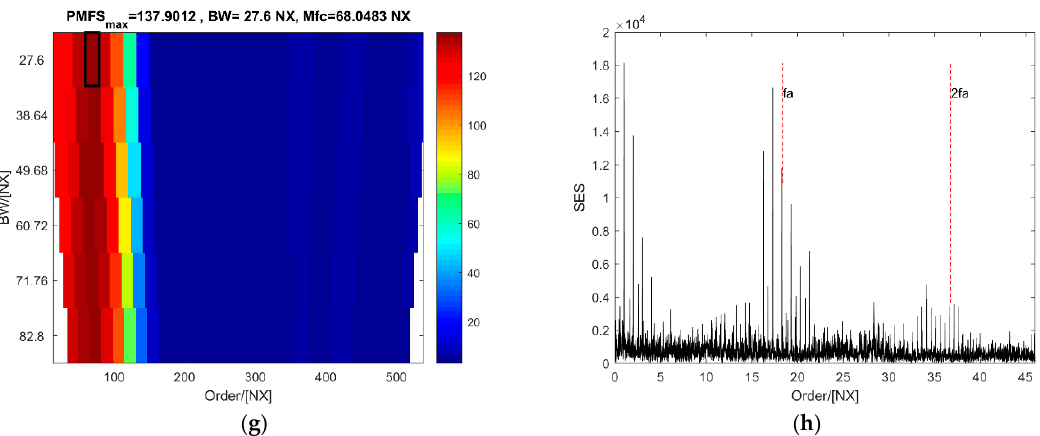
Figure 12. The analysis results of the case of outer ring defect with a slight acceleration: ( a , b ) the protugram and the SES of its optimal order band; ( c , d ) the PMgram and the SES of its optimal order band; ( e , f ) the enhanced kurtogram and the power spectrum of its optimal order band; ( g , h ) the PMFSgram and the SES of its optimal order band